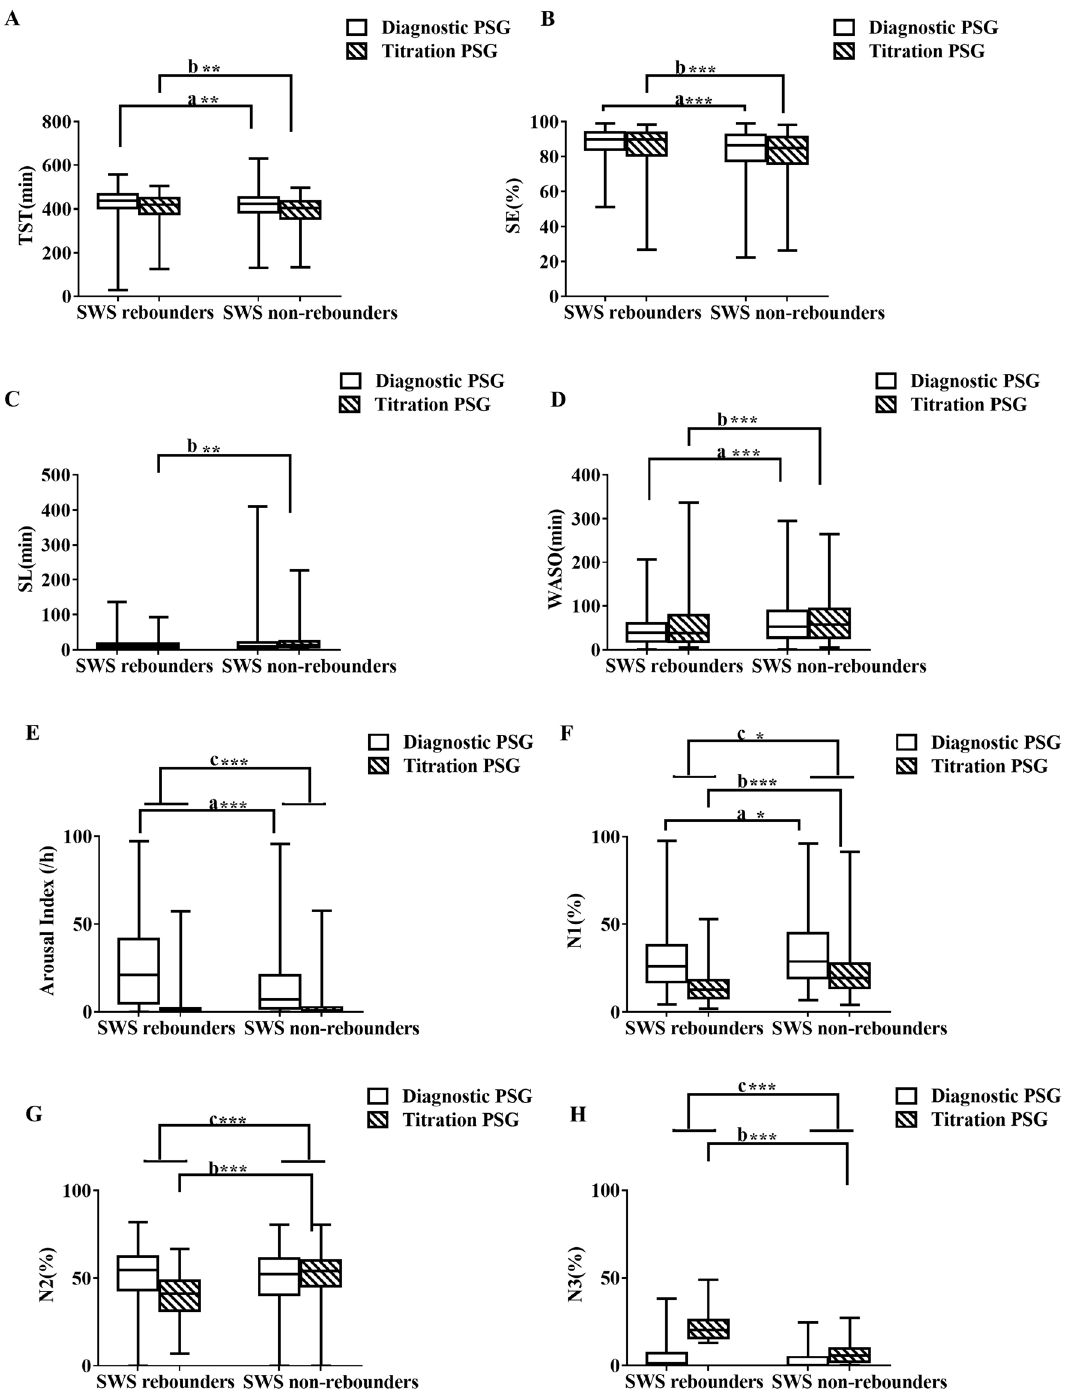
Figure 3. The change from diagnostic PSG to pressure titration PSG between and SWS rebounders and non- SWS rebounders. The figures showed the change of diagnostic and pressure titration PSG in TST ( A ), SE ( B ), SL ( C ), WASO ( D ), Arousal Index ( E ), %N1 ( F ), %N2 ( G ), % N3 ( H ), %REM ( I ), AHI ( J ), Mean duration of apneas and hypopneas ( K ), Nadir SpO 2 ( L ), Mean SpO 2 ( M ), ODI ( N ) between SWS rebounders and non–SWS rebounders. a, comparison of diagnostic PSG parameters between SWS rebounders and non-SWS rebounders; b, comparison of pressure titration PSG parameters between SWS rebounders and non-SWS rebounders; c, comparison of the change from pressure titration to diagnostic PSG parameters between SWS rebounders and non-SWS rebounders. * < 0.05, ** < 0.01, *** < 0.001. AHI apnea–hypopnea index, BMI body mass index, ODI oxygen desaturation index, PSG polysomnography, REM rapid eye movement sleep, SE sleep efficiency, SL sleep latency, SWS slow wave sleep, SpO 2 pulse oxygen saturation, TST total sleep time, WASO wake after sleep